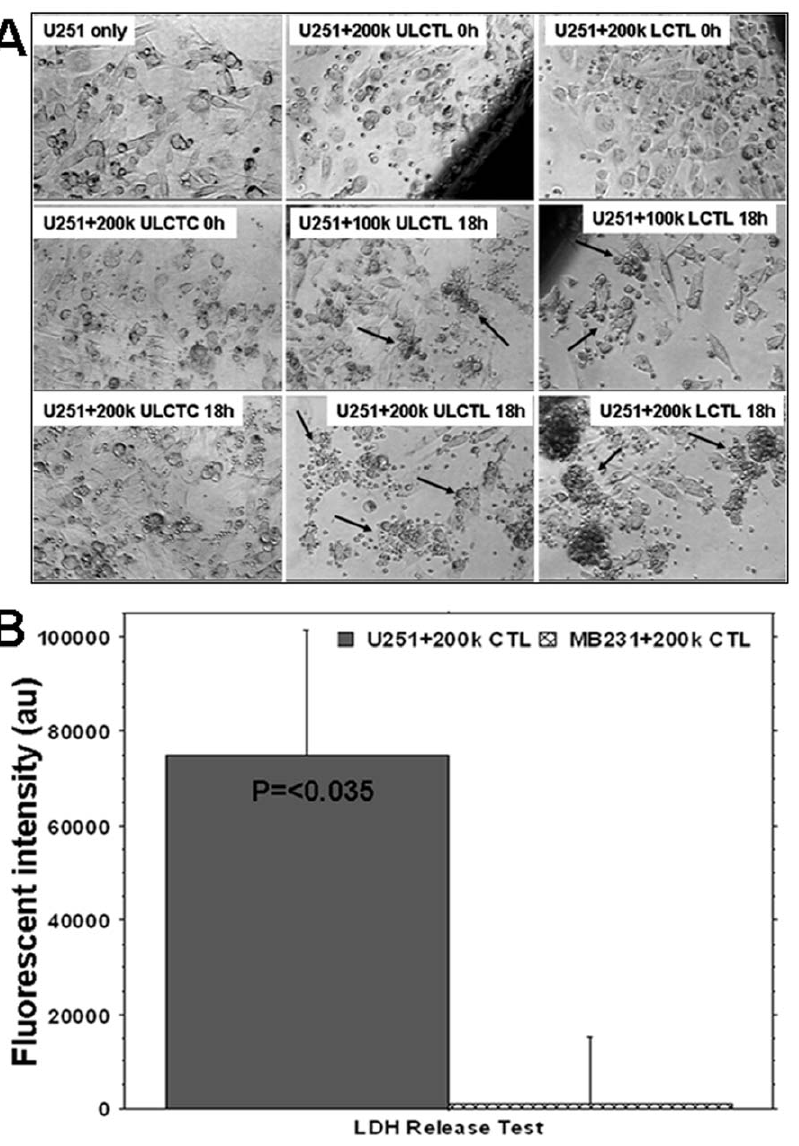
Figure 3. Specificity of labeled and unlabeled cytotoxic T-cells (LCTLs and ULCTLs, respectively) invitro . Figure 3A: U251 cells (100k) were plated in 24-well plates and grown until 90% confluent. Then unlabeled control T-cells (ULCTCs), LCTLs or ULCTLs were added to the cultures (100k and 200k per well). The migration and specific accumulation of T-cells around the tumor cells were microphotographed at 0h and 18h of co-culture. Left column: Morphology of U251 alone and after incubation with 200k of CTC at 0 and 18 hours. There is no change in the morphology of U251 and CTC seems to be sitting on the tumor cells even after 18 hours of incubation. Middle column: Morphology of U251 cells at 0 and 18 hours after incubation with ULCTL. The ULCTLs seem to be sitting on the tumor cells at 0 hour. The specific accumulation of ULCTLs around the tumor cells (arrows) was seen after 18 hours for both 100k and 200k ULCTLs conditions. Compared to the morphology of U251 cells at 0 hour, the dramatic changes in the morphology of U251 cells were observed. Cells become elongated and sparse. This phenomena was more pronounced at higher density (i.e. 200k) of ULCTLs. Right column: Similar to ULCTLs, LCTLs also show similar phenomena of specific accumulation around the tumor cells (arrows) and changes in the morphology of U251 cells. Figure 3B: Both U251 (100k) and human breast cancer cells (MBA-MD-231, 100k) were incubated in their respective media (1 ml in 24-well plate) in the presence or absence of 200k CTLs overnight. On the next day, supernatants from all the conditions were collected and the lactate dehydrogenase (LDH) contents were determined. Average fluorescent values detected in the supernatant of U251 and MBA-MD-231 cultures without CTLs were deducted from the fluorescent values detected in the corresponding cell lines in the presence of CTLs. The data are expressed as mean 6 SEM. Significantly higher (p= , 0.017) LDH activity was observed in U251 culture in the presence of CTLs indicating specificity of the sensitized